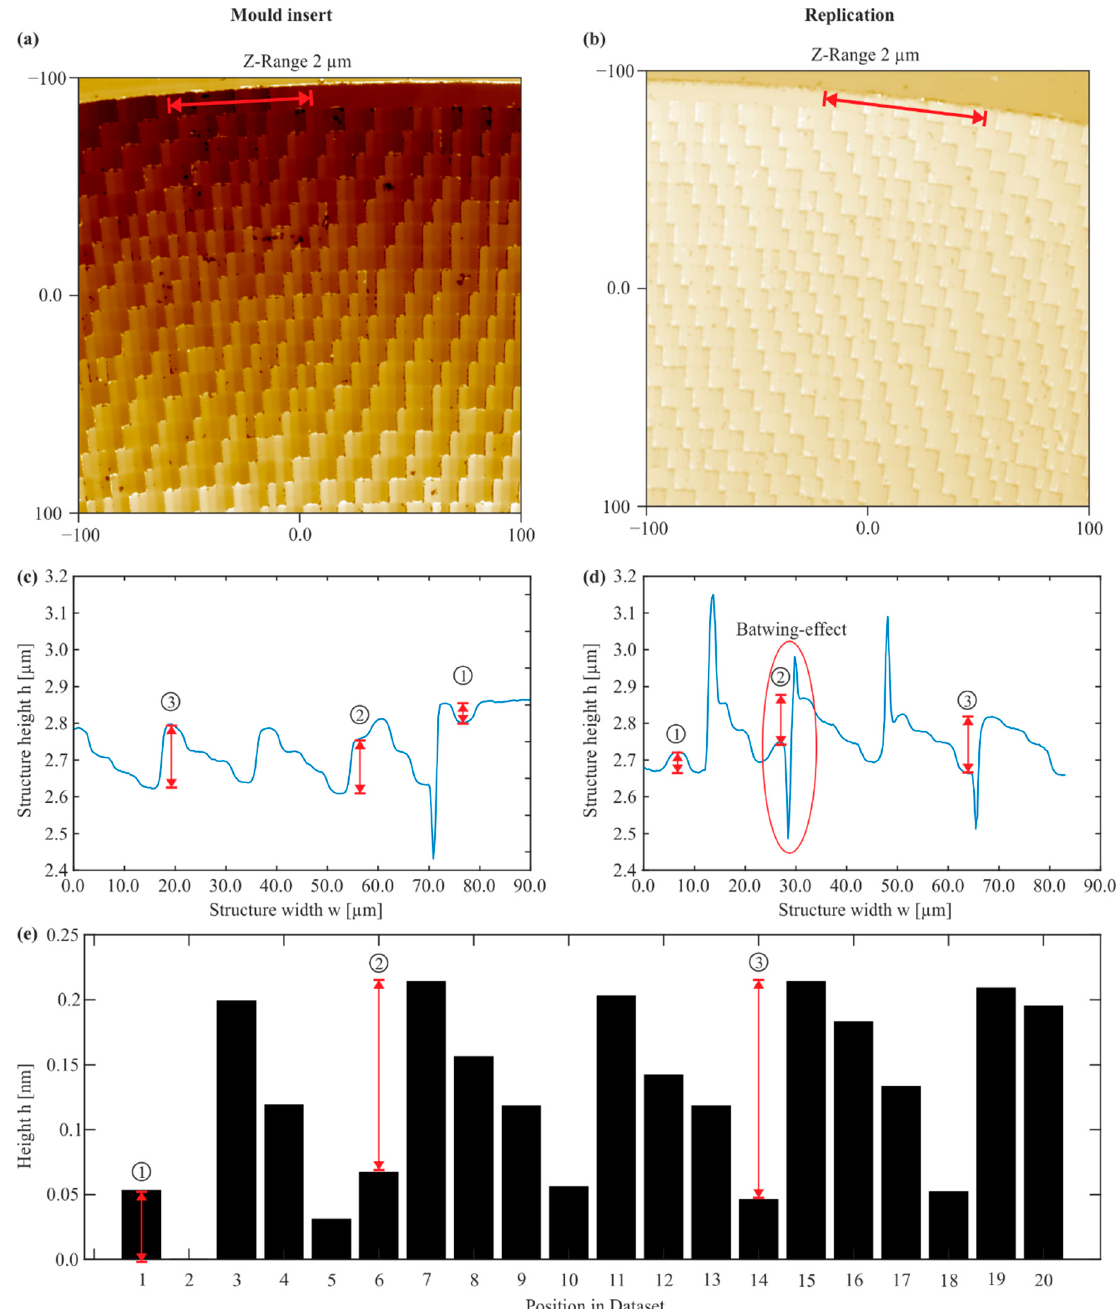
Figure 4. Comparison of mold and replication surface structured with a test structure, ( a , b ) white light interferometric measurements and ( c , d ) cross sections. ① , ② and ③ indicate exemplary positions for cross referencing between the measurements ( c – e ).